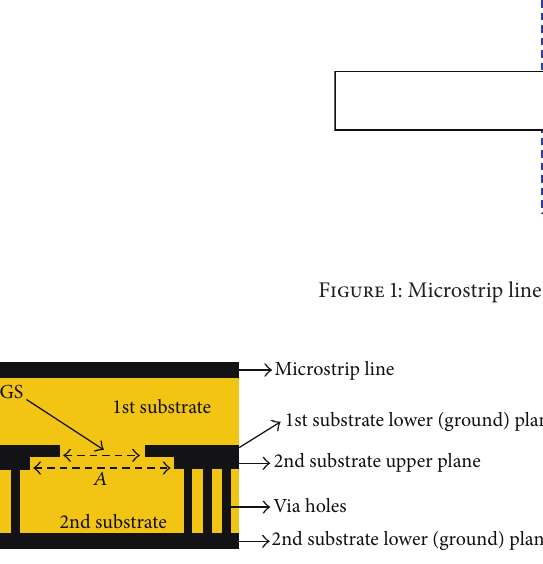
Figure 2: DGS line using the double-layered substrate. Area “ 𝐴 ” completely contains the DGS patterns.